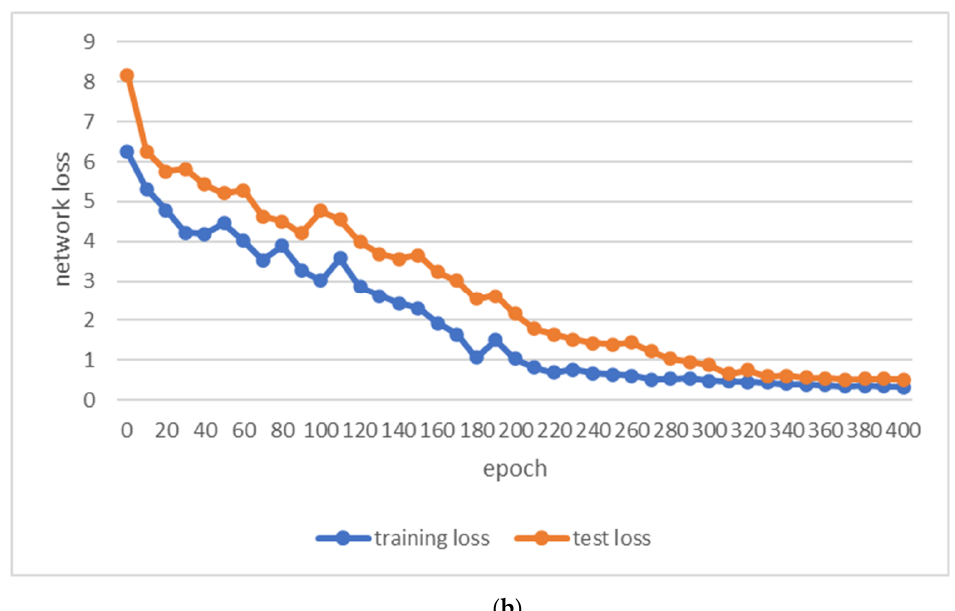
Figure 7. Network loss of the training set and test set in the training process: ( a ) network loss in the unsupervised training stage; ( b ) network loss in the supervised training stage.